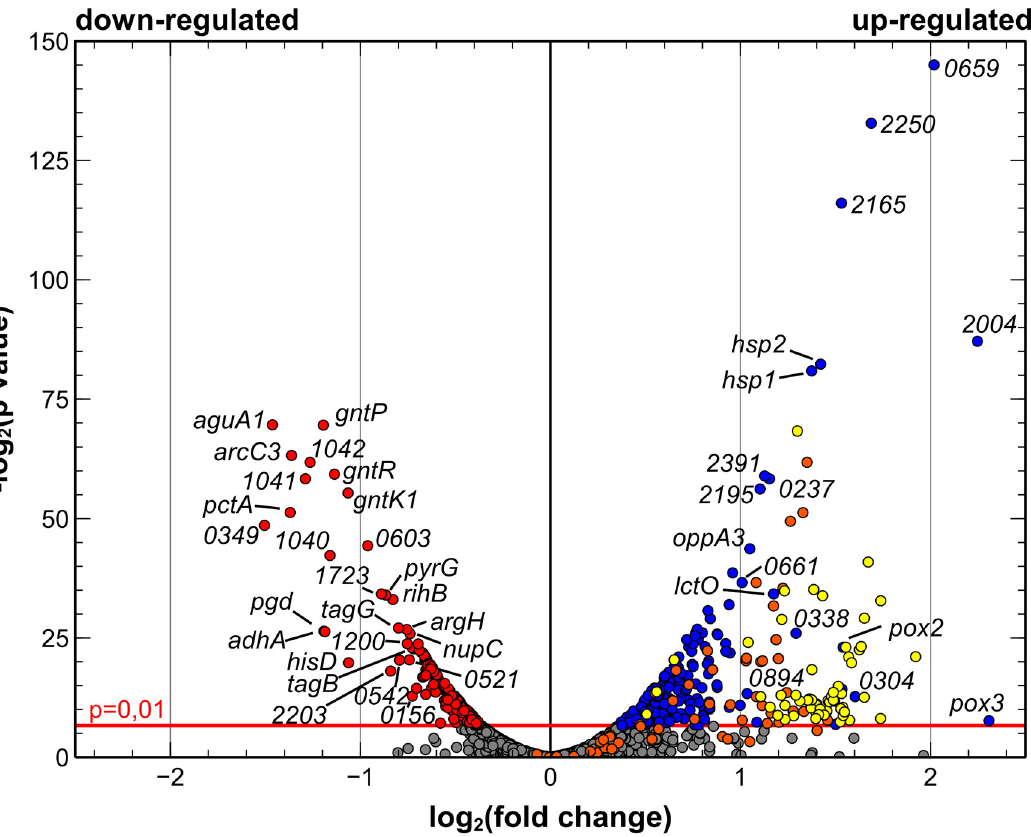
Fig 2. Volcano plot representing transcriptional levels for L . buchneri CD034 genes under aerobic vs . anaerobic conditions. For each protein encoding gene the − log 2 (p-value) is plotted against its log 2 (fold change). Genes up-regulated (p < 0.01) under aerobic conditions are colored blue while down-regulated genes are colored red. Genes found to be located between bacteriophagous attachment sites are colored in yellow ( Φ Lbu-1 ) and orange ( Φ Lbu-2 ) irrespective of their relative transcriptional levels. For genes with gene names that were found to be highly up- (see Table 3) or down- (see Table 4) regulated the gene name is given. Abbreviations represent gene names: pox2 , -3 : pyruvate oxidase; lctO : lactate oxidase; hsp1 , -2 : molecular chaperones; oppA3 : oligopeptide transport system, substrate binding protein; arcC3 : carbamate kinase; aguA1 : agmatine deiminase; pctA : putrescine carbamoyltransferase; gntP : H+/gluconate symporter; gntR : gluconate operon transcriptional regulator; gntK1 : gluconokinase; pyrG : CTP synthetase; rihB : ribosylpyrimidine nucleosidase; pgd : 6-phosphogluconate dehydrogenase; adhA : alcohol dehydrogenase; hisD : histidinol dehydrogenase; tagG : teichoic acid permease; tagB , teichoic acid biosynthesis protein; argH : argininosuccinate lyase; nupC : pyrimidine specific nucleoside symporter. For genes lacking gene names the index numbers of their respective locus tags (LBUCD034_XXXX) are given.